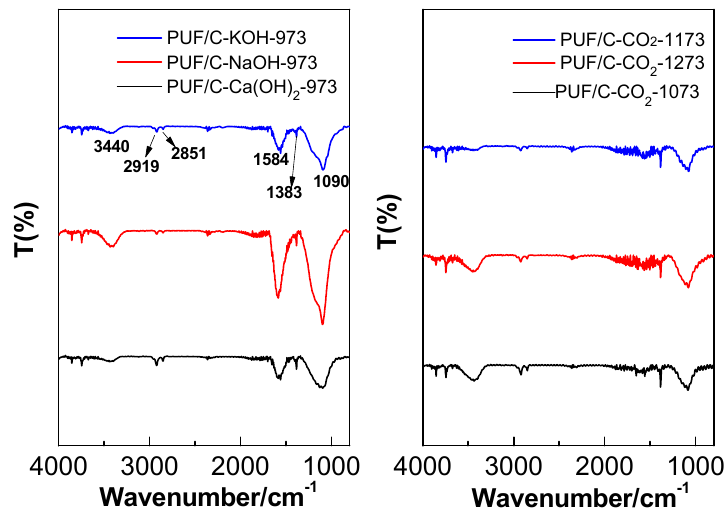
Figure 2. SEM images of the PUF/C ( a ), PUF/C-Ca(OH) 2 -973 ( b ), PUF/C-NaOH-973 ( c ), PUF/C-KOH- 973 ( d ), PUF/C-CO 2 -1173 ( e ), PUF/C-CO 2 -1273 ( f ), and TEM images of PUF/C-CO 2 -1173 ( g ) and PUF/C-CO 2 -1273 ( h ). The inset in ( a ) is a photo showing the morphology of waste polyurethane foams.